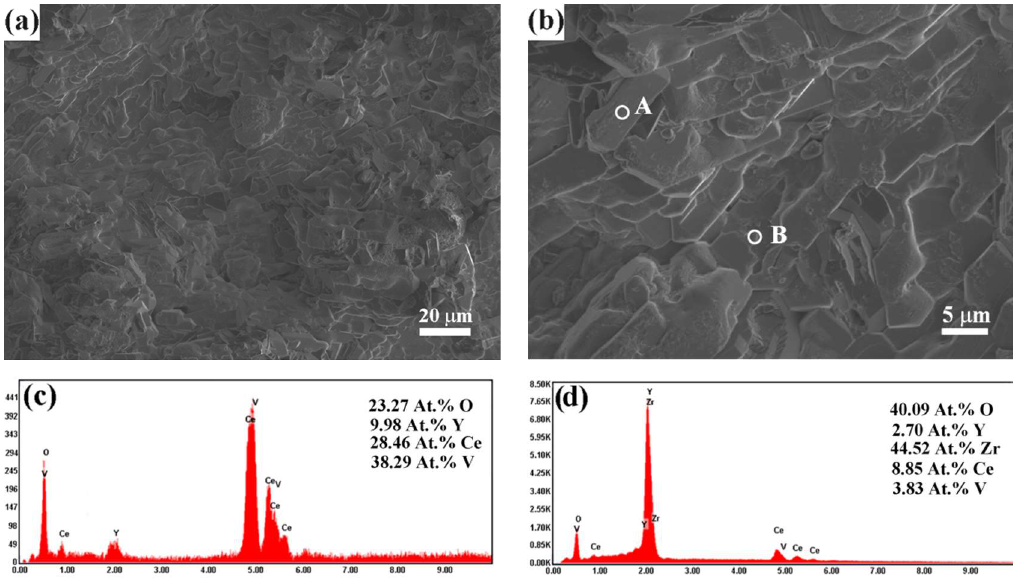
Figure 10. The SEM surface morphology of the plasma-sprayed coating after the hot corrosion test: Figure 11. The SEM surface morphology of the dotted coating after the hot corrosion test: ( a ) the ( a ) lower magnification; ( b ) higher magnification of image ( a ). EDS analysis of ( c ) Spot A and ( d ) Spot B. dotted unit; ( b ) higher magnification of image ( a ); ( c )the boundary of the dotted unit; and ( d ) higher magnification of image ( c ). EDS analysis of ( e ) Spot C and ( f ) Spot